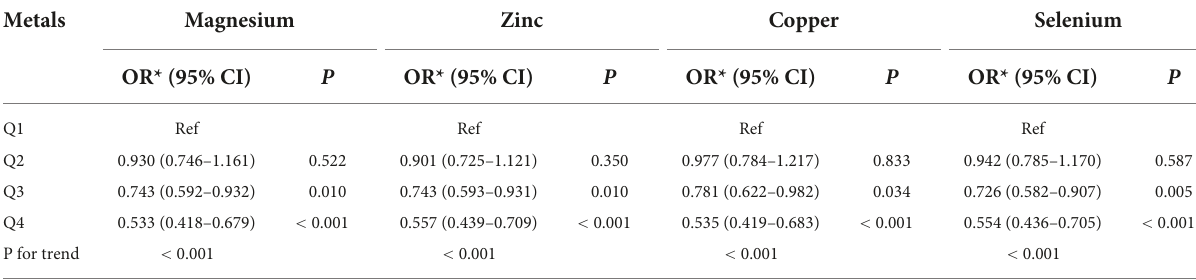
TABLE 3 Multivariate logistic regression analysis of the relationship between dietary metal intake and erectile dysfunction in national health and nutrition examination survey (NHANES) 2001–2004 before propensity score matching